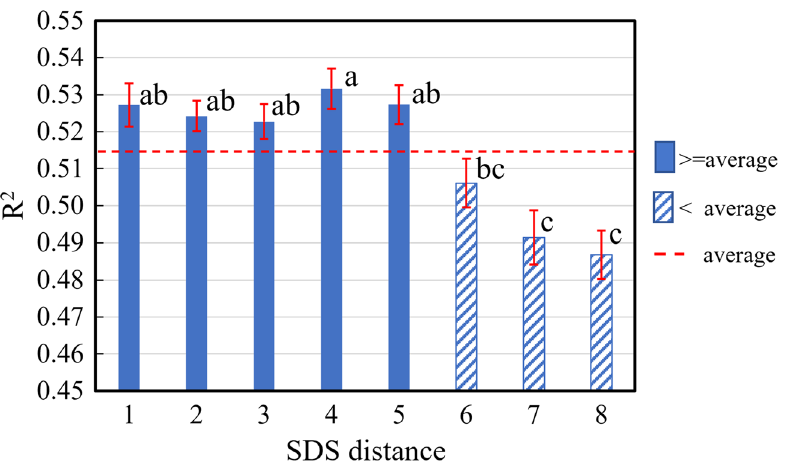
Figure 7. Average (± SE) R 2 for PLS models for the whole flesh based on interactances collected at different SDS distances. Significant differences were observed between short (1 through 5) and longer (6–8) detector distances ( p < 0.001). Models for the short detector distances (1 through 5) achieved a higher R 2 than the averaged R 2 , indicating a higher predictability than those for the longer detector distance (6 through